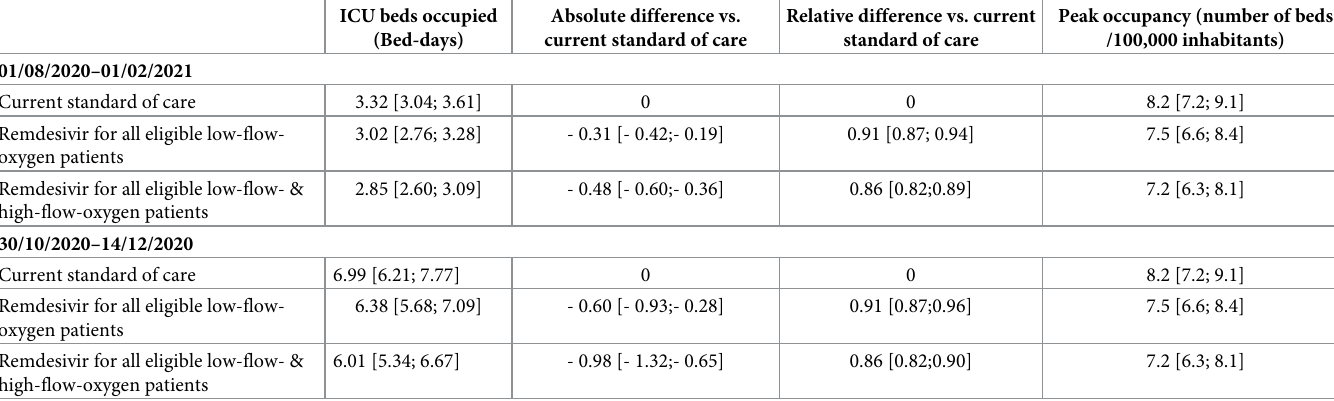
Table 2. Estimations of the total number of ICU bed-days occupied between 01/08/2020 and 01/02/2021 associated with the use of remdesivir for all eligible patients with low-flow-oxygen therapy and for the use of remdesivir for all eligible patients with low-flow-and high-flow-oxygen therapy since 01/08/2020 relative to the cur- rent standard of care in